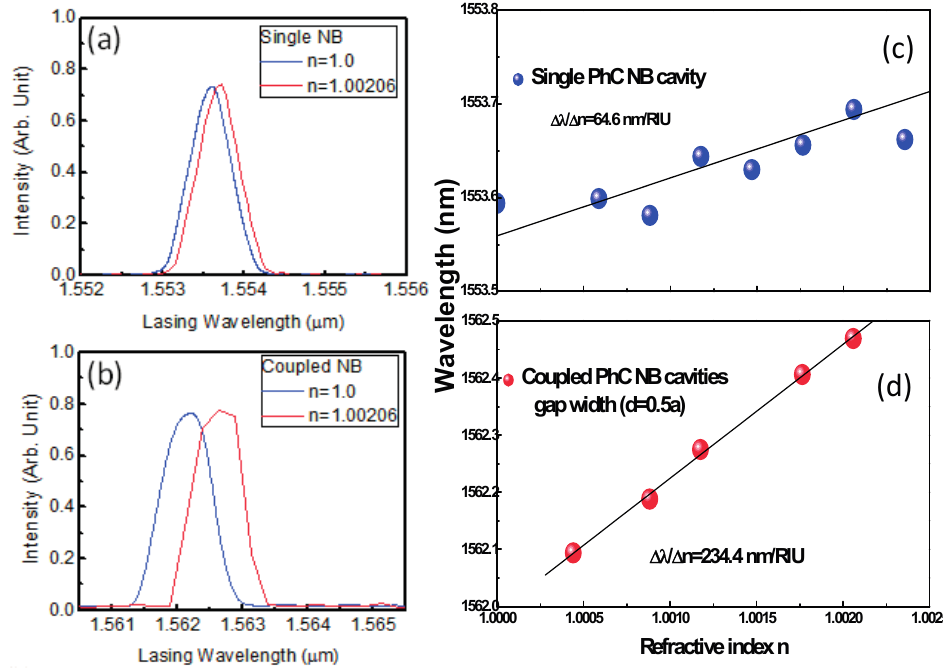
Figure 9. The measured lasing spectra from ( a ) the single NB cavity and ( b ) the coupled NB cavity with refractive indices of 1.0 (blue) and 1.00206 (red). Lasing wavelengths correspond to refractive index variation. The blue and red dots represent ( c ) single and ( d ) laterally-coupled PhC NB cavity with gap distance